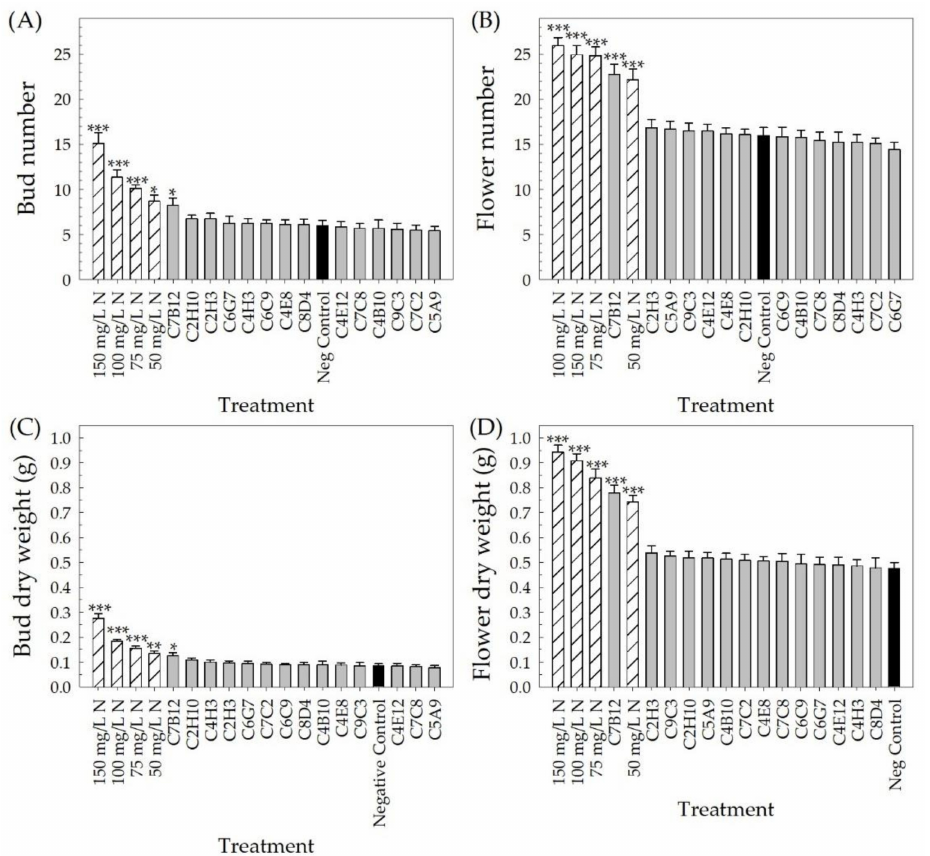
Figure 3. Flowering performance parameters measured in the greenhouse validation trial after application of the 14 bacterial strains selected from the high-throughput greenhouse trials to Petu- nia × hybrida ‘Picobella Blue’ ( n = 12). Bud number ( A ) and flower number ( B ) were measured at harvest, 4 weeks after transplant, and bud dry weight (DW) ( C ) and flower DW ( D ) were mea- sured after drying in a forced air oven (49 ◦ C). All plants treated with bacteria were fertilized with 25 mg L − 1 N (gray bars). The black bar represents the negative control (no bacterial treatment) fertil- ized with 25 mg L − 1 N, and the white bars with slanted lines represent the four positive controls (no bacterial treatment) fertilized with either 50, 75, 100, or 150 mg L − 1 N. The treatments were compared to the negative control using Dunnett’s comparison. Significance is represented by *, **, and *** at p ≤ 0.05, p ≤ 0.01, and p ≤ 0.001, respectively. Bars represent the mean, and error bars denote standard